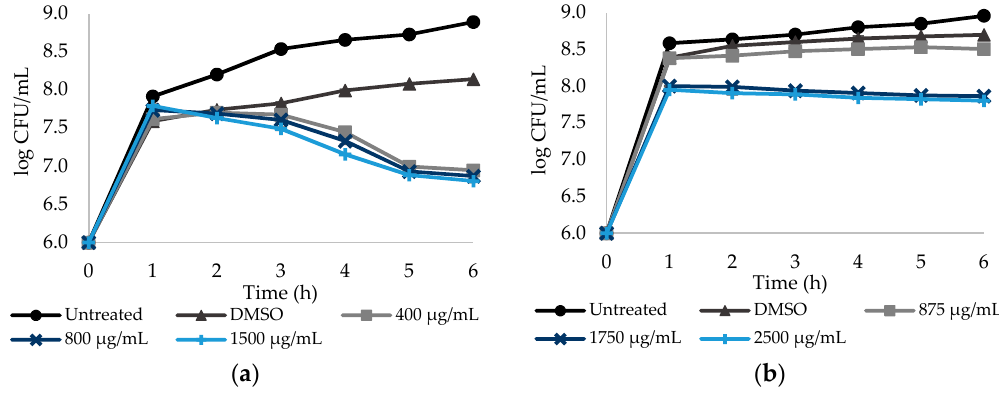
Figure 1. Dose–response curves. The y -axis reports the log CFU/mL of E. coli planktonic cells, while the x -axis reports the period of 6 h of exposure to the NSAIDs: ( a ) PXC (piroxicam) at three different concentrations (1/2× MIC, MIC and a concentration above the MIC), grown in broth culture medium with lactose and treated with DMSO; ( b ) ASA (acetylsalicylic acid) at three different concentrations (1/2× MIC, MIC and a concentration above the MIC), treated with DMSO. Cells without NSAIDs and cells with DMSO were used as negative controls. Mean values ± SD are presented.